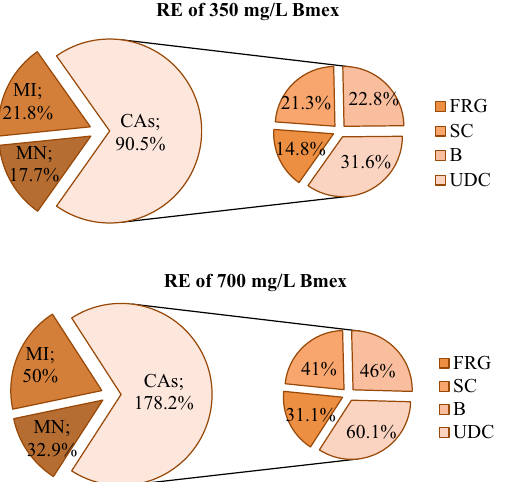
Figure 7. RE of 350 mg/L and 700 mg/L doses of Bmex against MI and